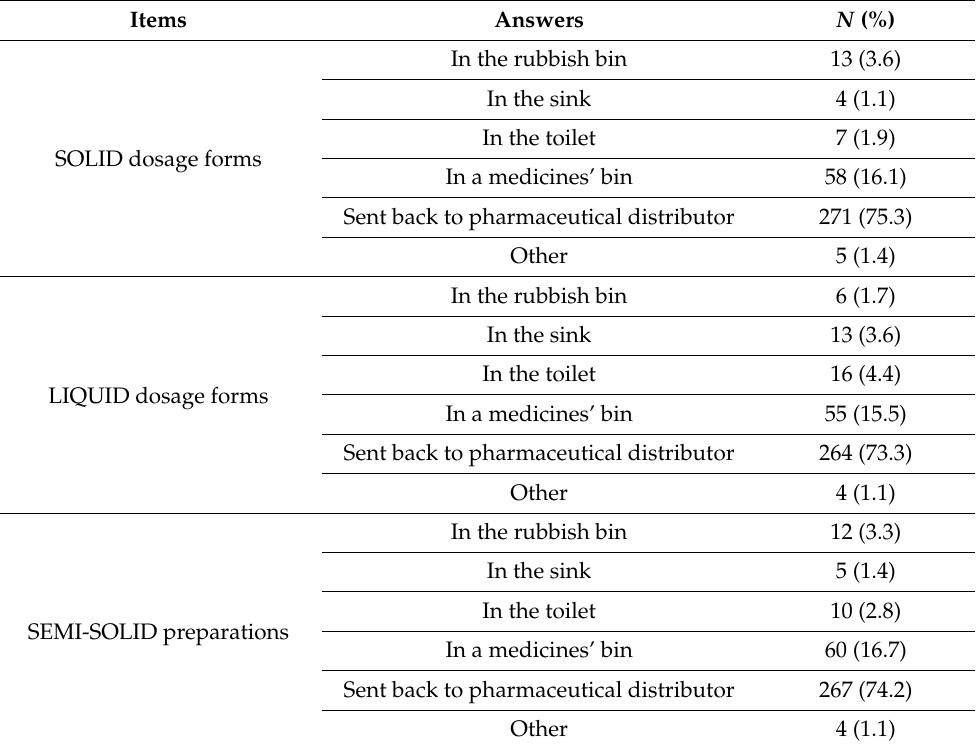
Table 2. Disposal approaches of unused medications among community pharmacists based on various dosage formulations ( n = 360